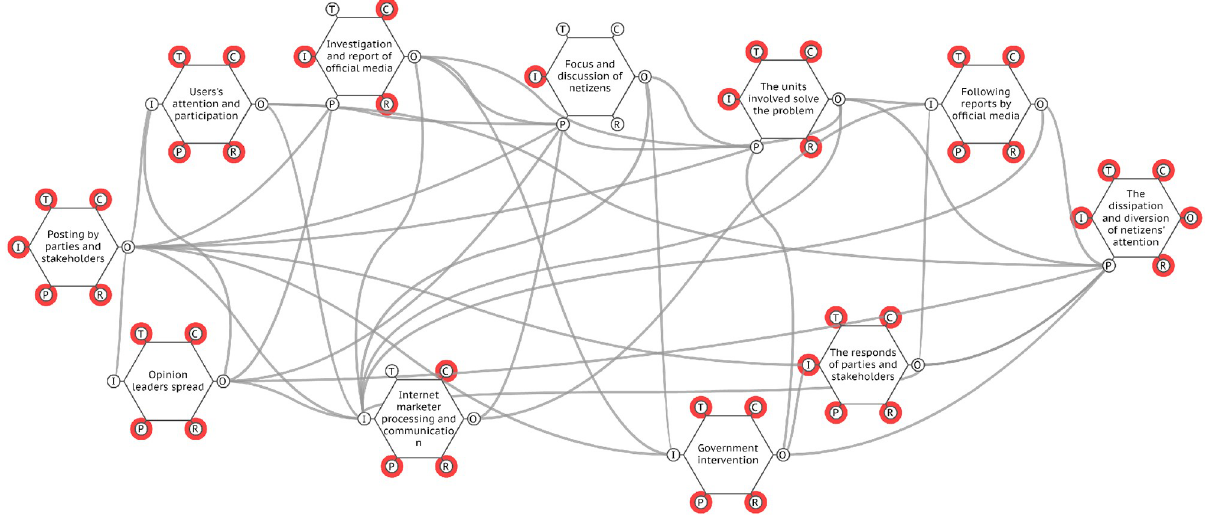
Fig 6. Functional resonance of network public